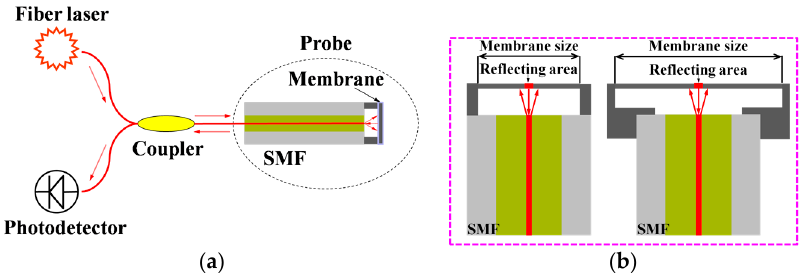
Figure 1. The schematics of ( a ) the whole fiber optic extrinsic Fabry-Perot interferometer (EFPI) sensor system; and ( b ) two assembly manners for the Fabry-Perot cavity with different membrane sizes.